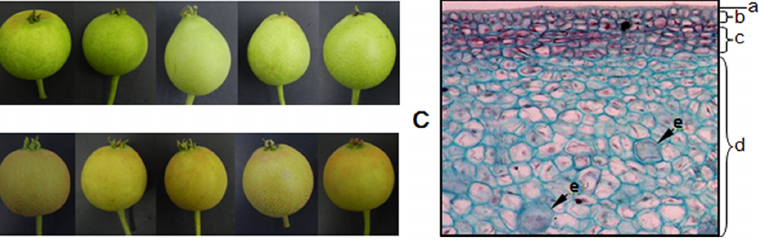
Figure 1. Pericarp pigmentation of sand pear cv. ‘Cuiguan 6 Qingxiang’ offspring, and microscopic structure of ‘Cuiguan’ young fruit pericarp (green) under 200 6 magnification. A, green-pericarp fruits at 80 day after flowering (DAP); B, russet-pericarp fruits at 80 DAP; C, a , e, cuticle layer (a),Epidermal cell layer (b),Cork cambium (c),Parenchyma cell layer (d), Stone cell (e).